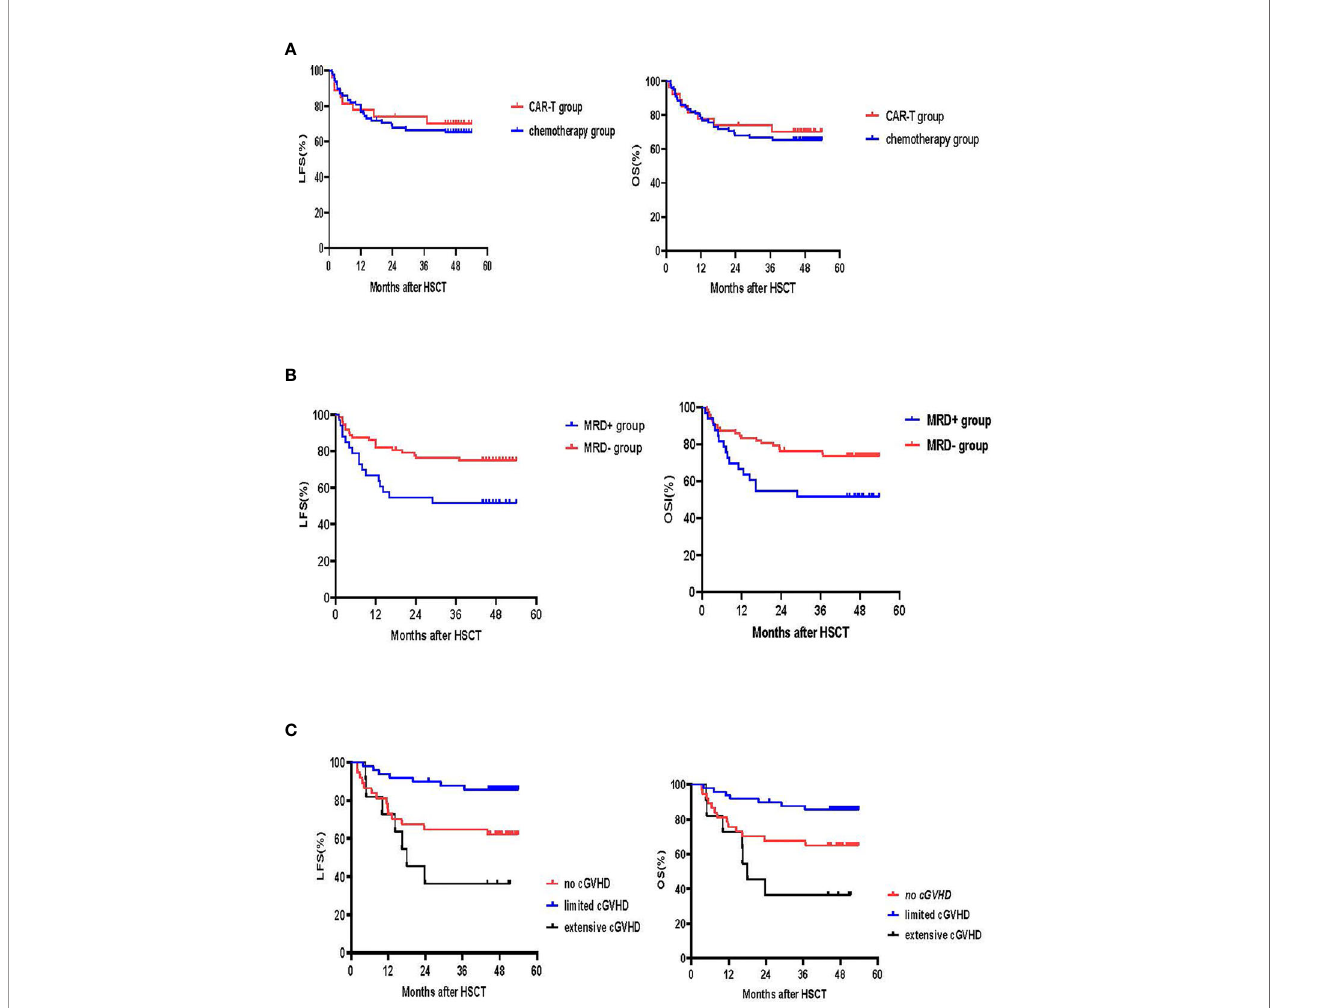
FIGURE 5 | LFS and OS. (A) LFS and OS in the CAR-T and chemotherapy groups. The 4-year LFS for the CAR-T group was 70.2% (95% CI:53.0, 87.4%) vs. 64.1% (95% CI:53.5, 74.7%) for the chemotherapy group (p=0.63). The 4-year OS for the CAR-T group was 70.2% (95% CI:53.0, 87.4%) vs. 65.4% (95% CI:54.8, 76.0%) for the chemotherapy group (p=0.681) (B) LFS and OS according to MRD. The 4-year LFS for patients who achieved MRD- CR was 72.2% (95% CI:61.8, 82.6%) and 51.5% (95% CI:34.4, 68.6%) for those that had an MRD+ CR (p=0.024). The 4-year OS for the MRD- CR group was 73.6% (95% CI:63.4, 83.8%) and 51.5% (95% CI:34.4, 68.6%) for the MRD+CR group (p=0.02). (C) LFS and OS according to cGVHD. 4-year LFS for patients without cGVHD was 62.2% (95% CI:46.5, 77.9%), 85.6% (95% CI:75.8,95.4%) for those with limited cGVHD and 36.4% (95% CI:8.0, 64.8%) for those with extensive cGVHD (no vs. limited cGVHD, p=0.009; limited vs. extensive cGVHD, p<0.001; no vs. extensive cGVHD, p=0.20). 4-year OS for the no cGVHD group was 64.9% (95% CI:49.6, 80.2%), 85.6% for the limited cGVHD group (95% CI:75.8, 95.4%) and 36.4% for the extensive cGVHD group (95% CI:8.0, 64.8%) (no vs. limited cGVHD, p=0.019; limited vs. extensive cGVHD, p<0.001; no vs. extensive cGVHD, p=0.123).